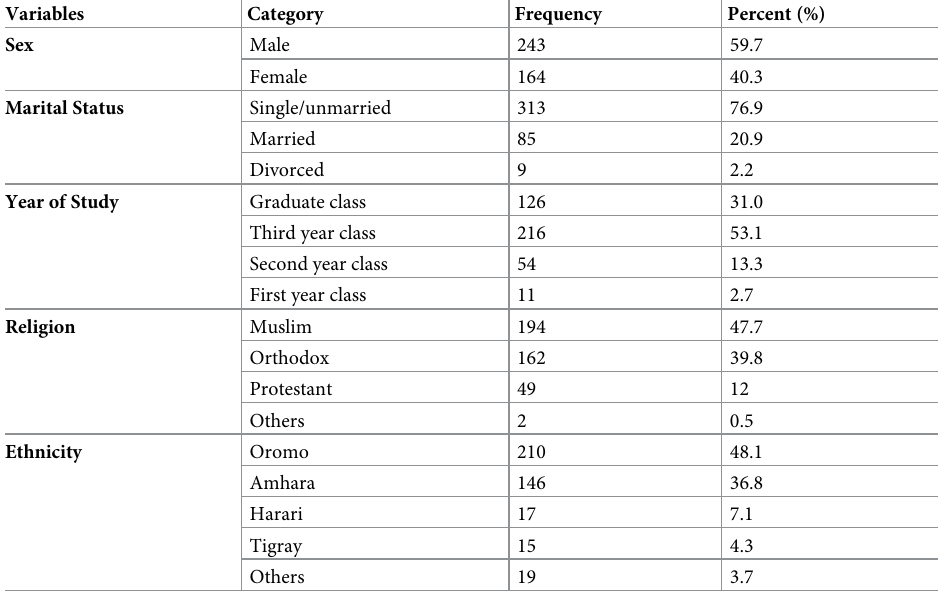
Table 1. Sociodemographic characteristics of the study participant, eastern Ethiopia,